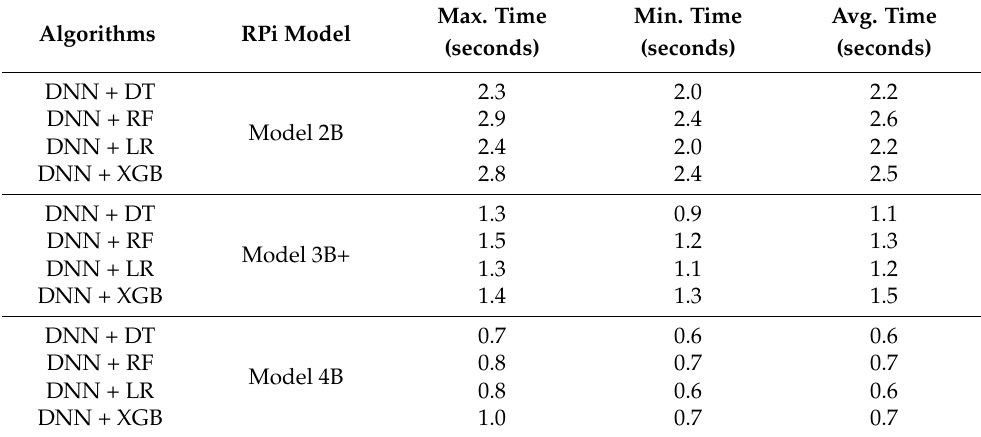
Table 5. Time that it takes for the system to classify a 4-s audio fragment using three different sensor models. Results are shown in seconds after 100